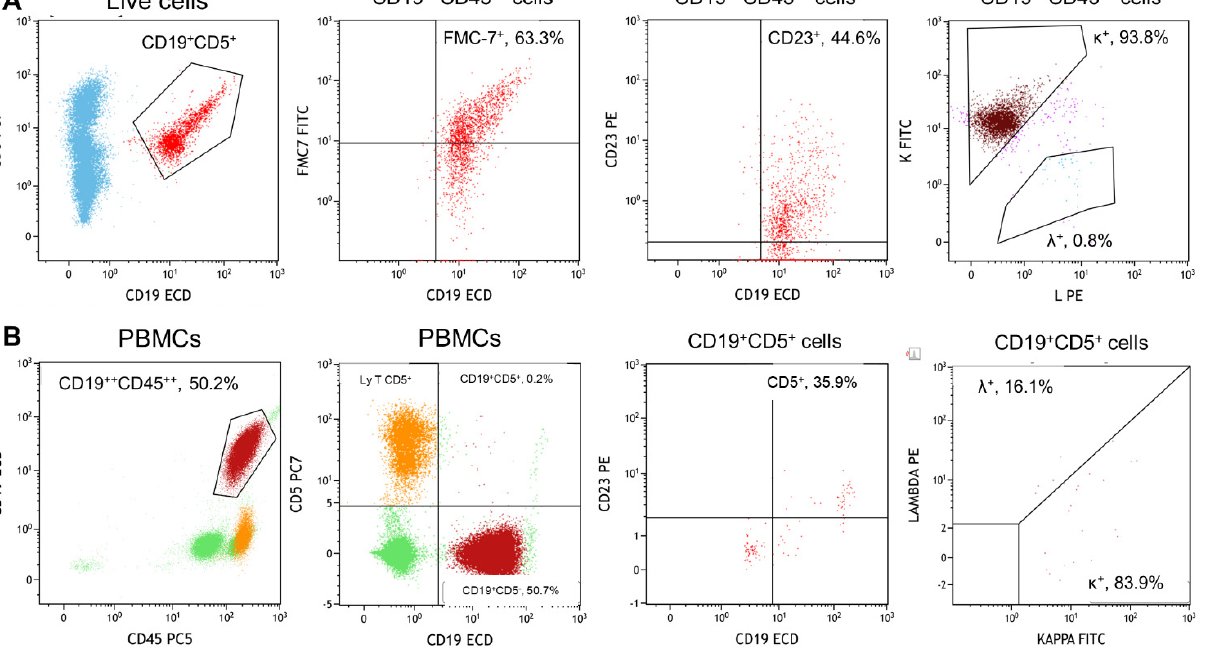
Figure 2. Flow cytometry characterization of chronic lymphocytic leukemia (CLL) and hairy cell leukemia (HCL) clones. ( A ) CLL clone after five years from diagnosis showing positivity for CD19, CD5, CD23, and SmIg κ . ( B ) Minimal residual disease of CLL clone at Richter’s disease diagnosis displaying a small CLL population positive for CD19, CD5, CD23, and SmIg κ . ( C ) HCL clone with negativity for CD10, CD5, CD23, CD43, and CD38, and positivity for CD20, CD22, FMC7, CD103, CD11c, CD25, CD49d, CD200, and SmIg κ . 4. Discussion In 1928, Richter’s syndrome has been described for the first time by Maurice N. Rich- ter in a CLL case with lymphadenopathies who evolved with liver and spleen enlarge- ments, resulting in patient’s dead [19]. In most cases, CLL transforms into an aggressive